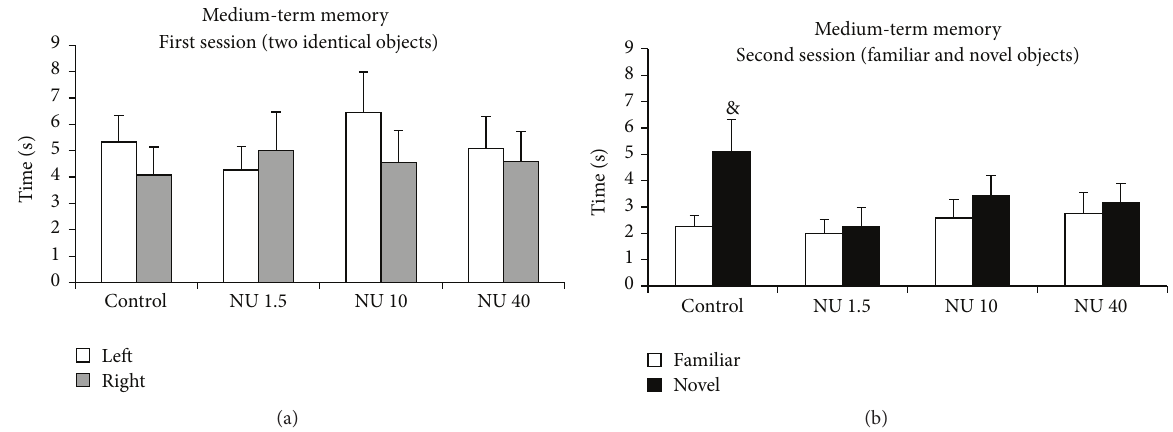
Figure 2: Medium-term memory of male rats exposed to 1.5, 10, or 40 mg ⋅ L −1 NU from birth for 9 months. (a) shows the time spent exploring one of the two identical objects (left or right objects) during the first session. (b) shows the time spent on the familiar or new objects during the second session. The data are expressed in seconds (s). Results are expressed as mean ± SEM; 𝑛 = 12 for each group; NU: natural uranium; & 𝑝 < 0.05 , significant difference from familiar object.